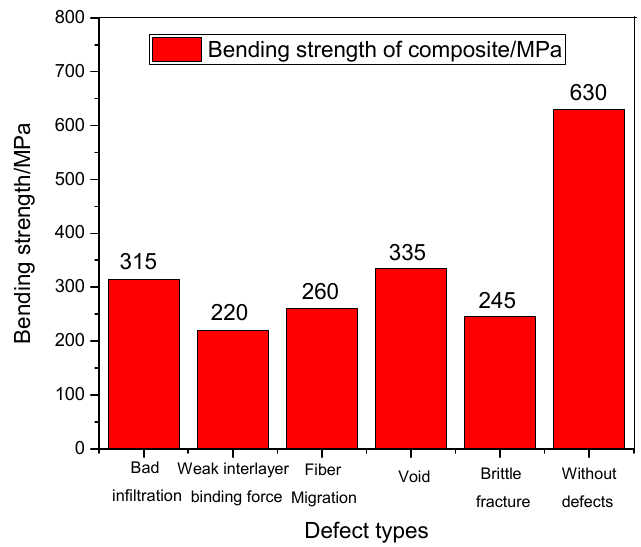
Figure 10. Properties comparison of composites under different defects prepared by ICM.